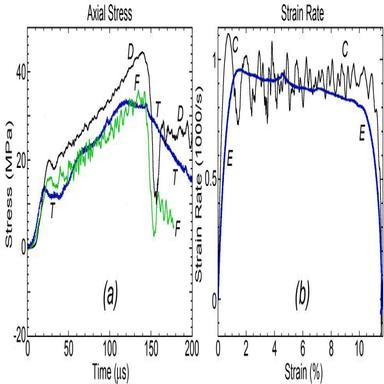
Comparison of the calculated stress curves F and D with the experimental stress curve T (a) and calculated strain rate curve C with the experimental strain rate E (b) for the pre-compacted calcite sand.